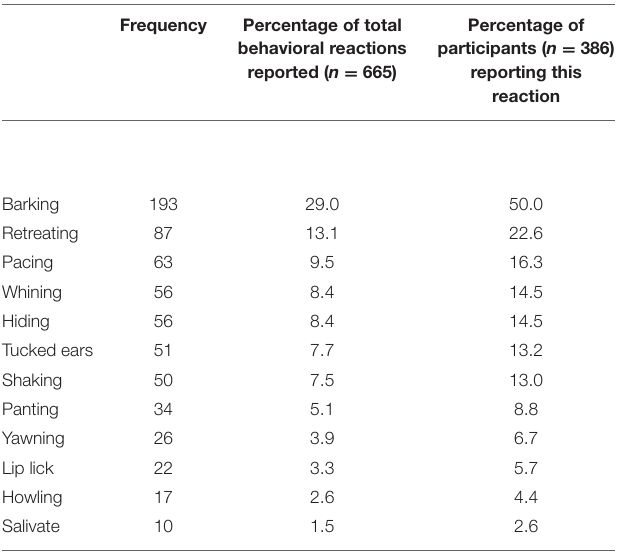
TABLE 4 | Types and frequencies of stress-related dog behaviors reported by owners ( n = 386) in response to household noises.